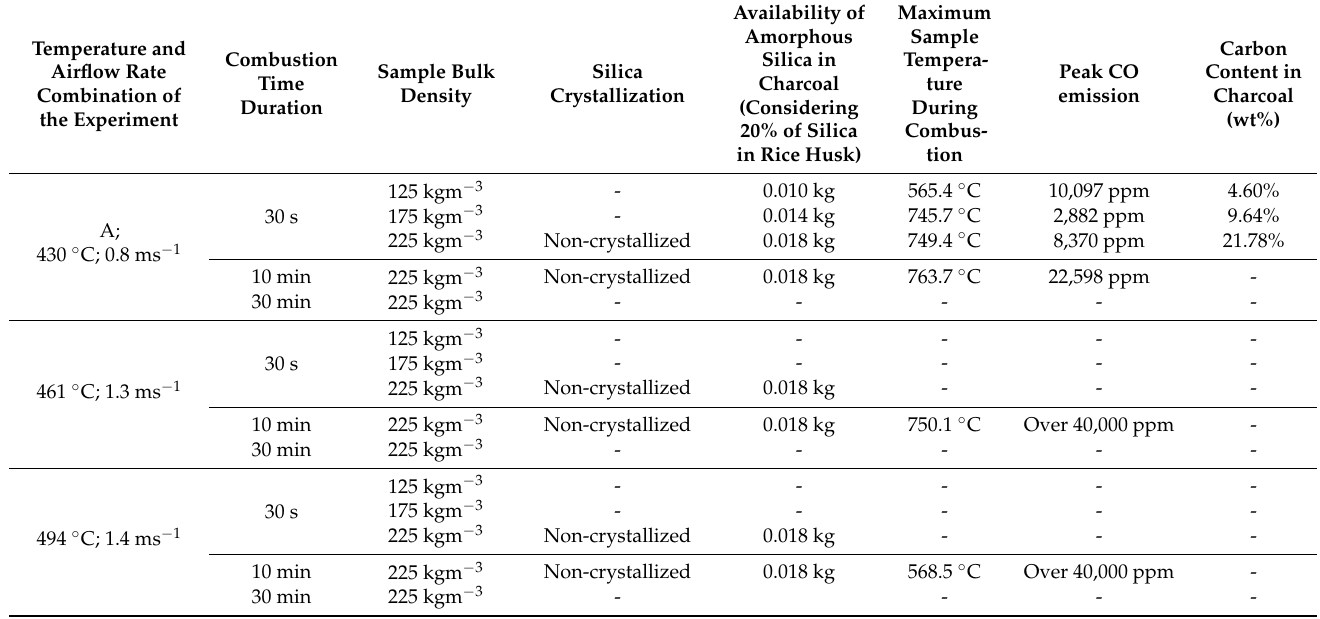
Table A1. Results from overall